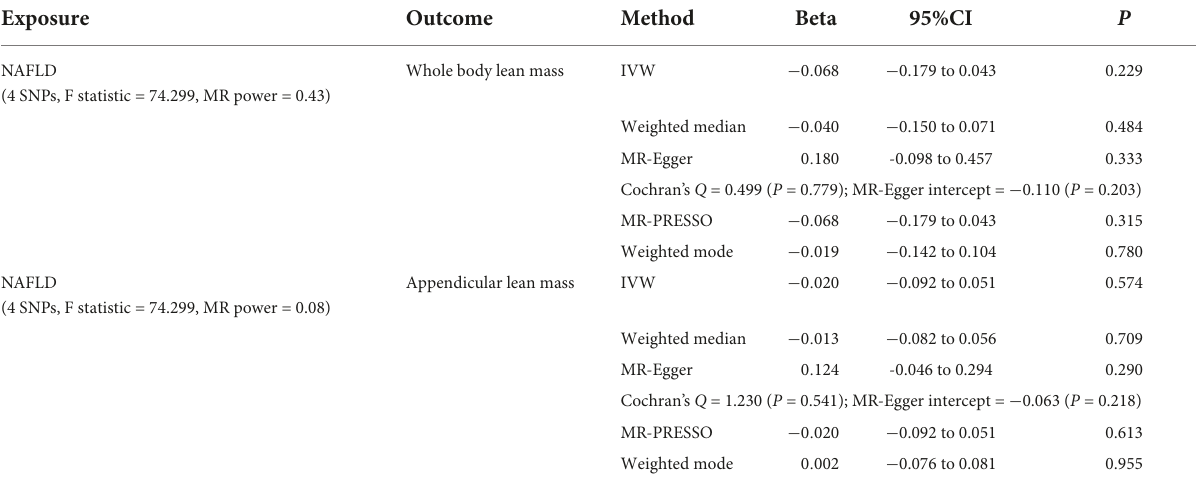
TABLE 4 MR estimates from different methods assessing the causal effect of NAFLD on lean body